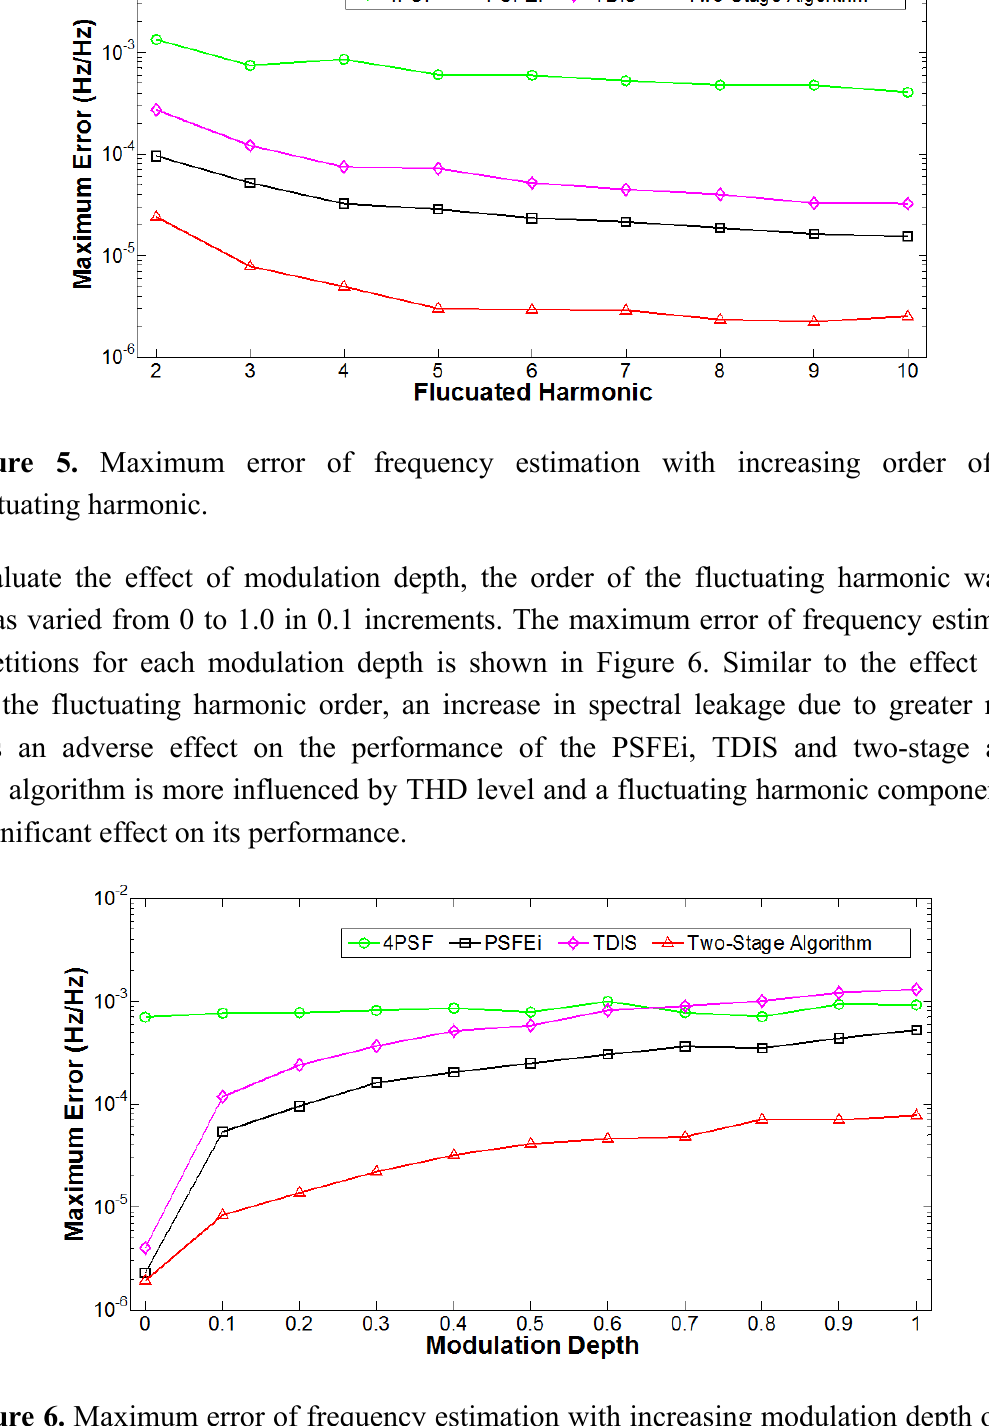
Figure 6. Maximum error of frequency estimation with increasing modulation depth of the third